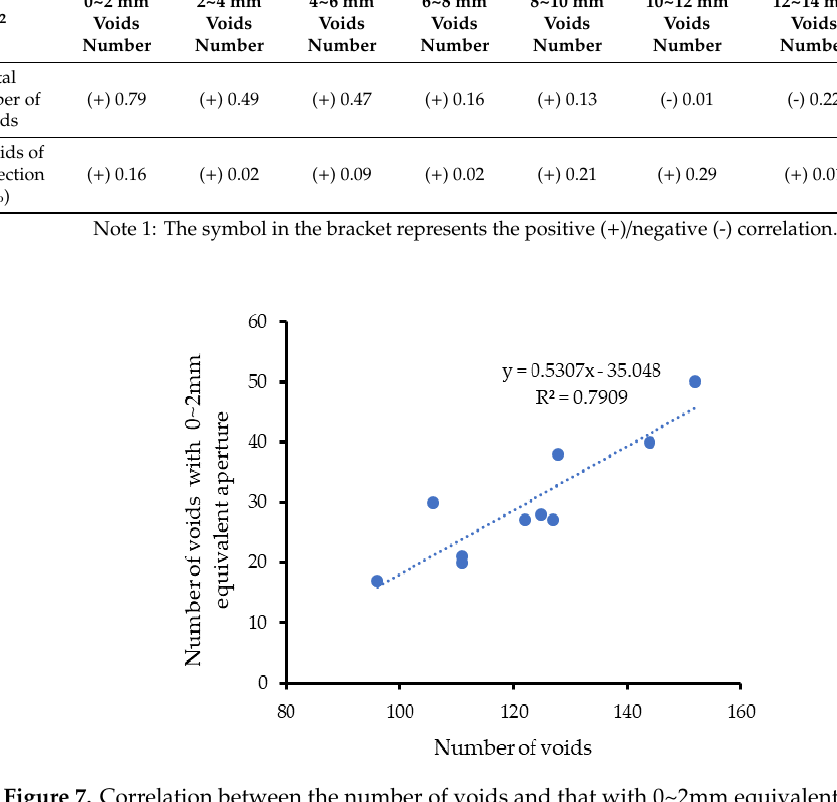
Figure 7. Correlation between the number of voids and that with 0~2mm equivalent aperture.